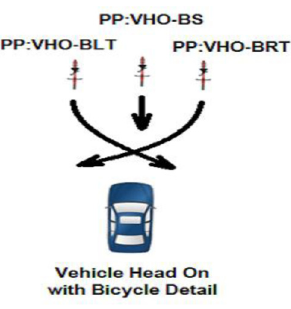
Figure 4 Crash geometry of PP:VHO scenarios